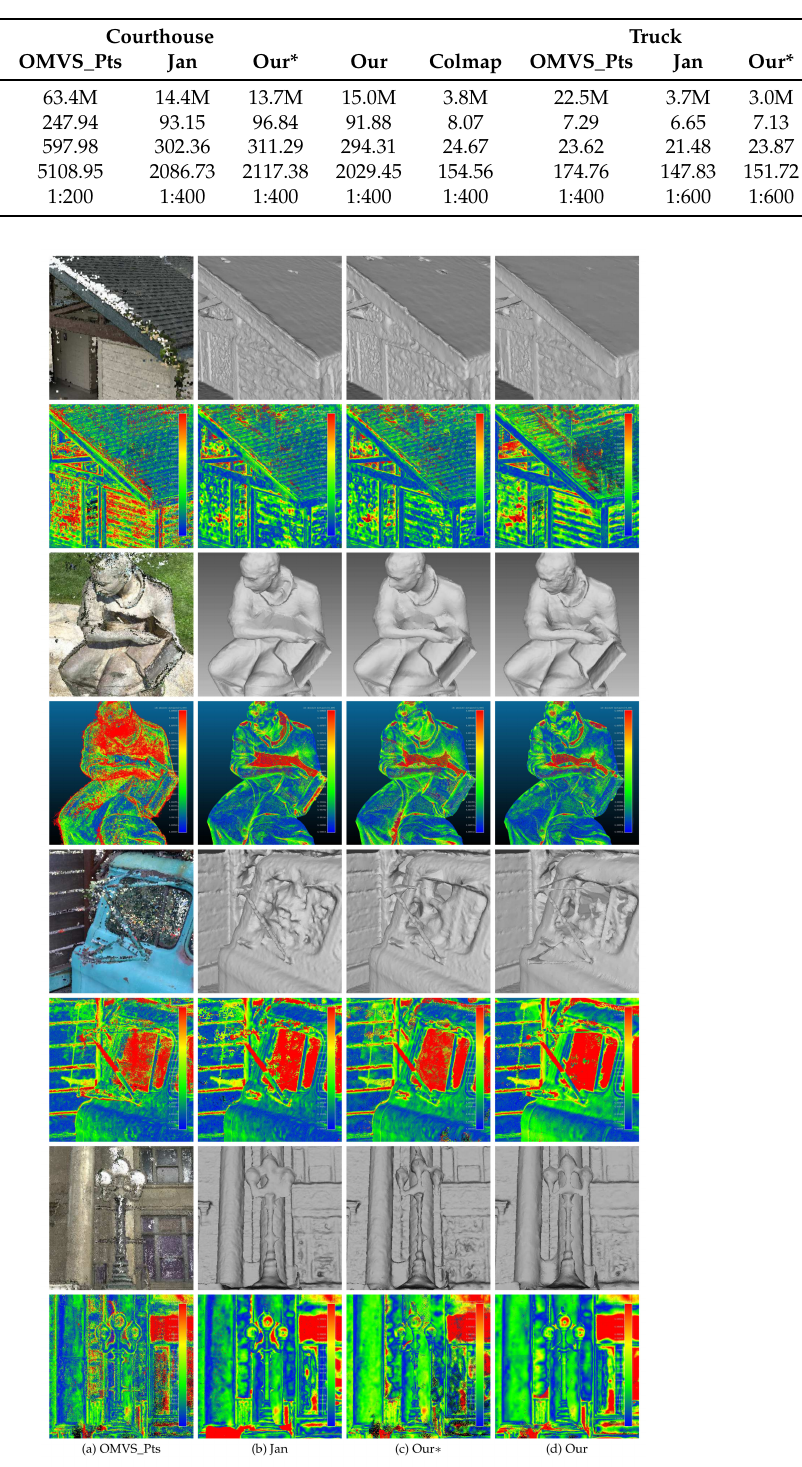
Figure 14. Detailed views of three methods on four scenes of the training set of Tanks and Temples dataset [40]. From left to right are: ( a ) the point cloud generated by OpenMVS; ( b ) the mesh of Jancosek and Pajdla [5]; ( c ) the mesh of the proposed method without the dense visibility technique; and ( d ) the mesh of the proposed method. In the even rows are the evaluation result (lower is better) of the corresponding local models in the odd rows through the method in [41]. The unit is m for all